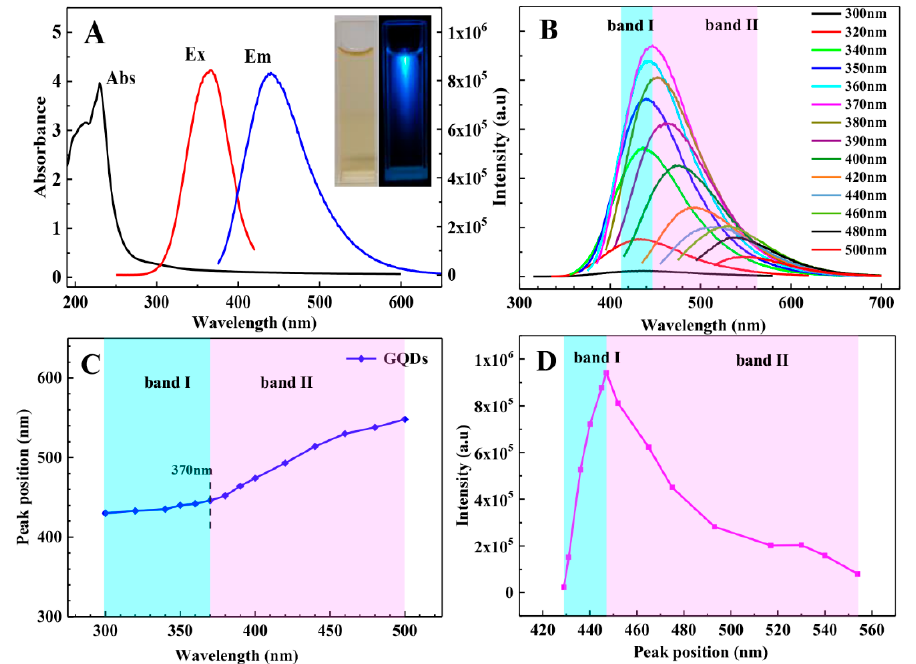
Figure 4. ( A ) The absorption, excitation and emission spectra of N-GQDs. Inset: from left to right are the N-GQDs aqueous solutions under ambient light and UV excitation (irradiated from an optical fiber), respectively; ( B ) the PL spectra of N-GQDs under excited different excitation wavelengths; ( C ) the peak positions and ( D ) the maximum intensities of the PL spectra varying with the excitation wavelengths in ( B ).